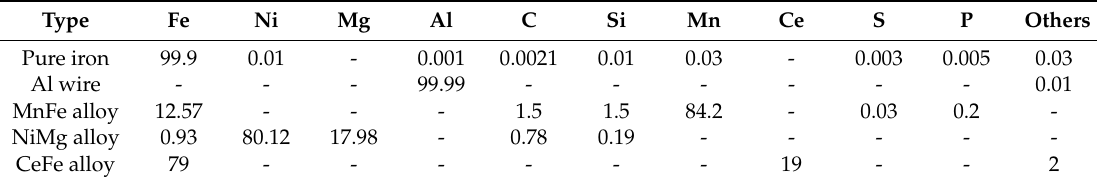
Figure 1. Schematic diagram of the experimental process. Table 1. Chemical composition of raw materials (mass fraction/%).